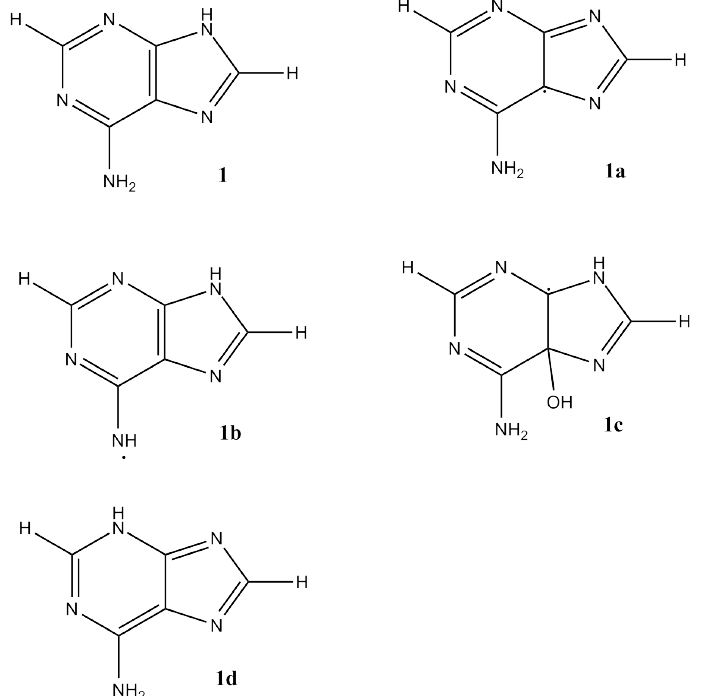
Figure 2. Reaction products of the electrolysis of adenine 1 . Anodic reaction: 1a , 1b , and 1c , cathodic reaction: 1d .